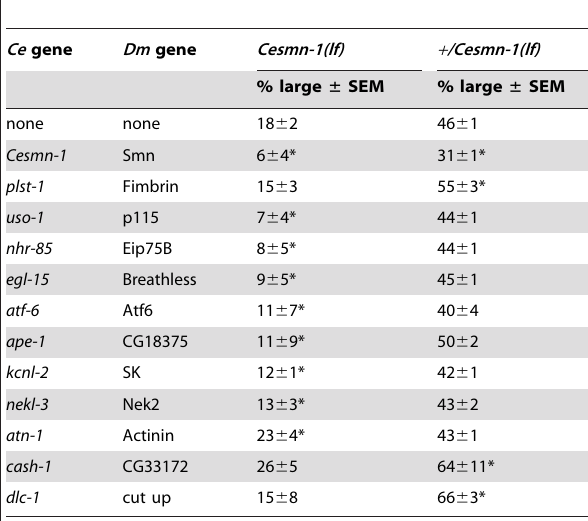
animals, a growth ratio of large to small animals was determined for each clone for Cesmn-1(lf) and for + /Cesmn-1(lf) genotypes. If the RNAi clone growth ratio was more than 2 standard deviations away from the mean for Cesmn-1(lf) animals and within 0.7